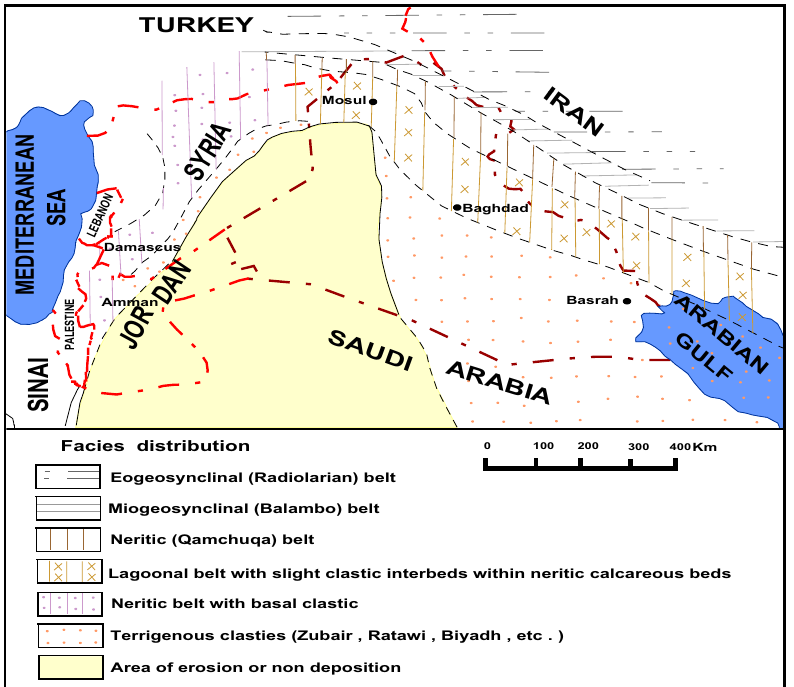
Figure 3. Paleogeography map of the Late Berriasian—Aptian period, modified form 4 by using Didger 3. The miogeosynclinal furrow indicate that in northeastern Iraq the boundary of Balambo trough was formed by ridge indicated by shallow water carcareous sediments in the wider Surkev–Norbab–Avroman area. On the area of unstable shelf, and on the marginal parts of the stable shelf,—three zones, with different sedimentary sequences, can be distinguished in this figure: ( a ) The neritic belt, is relatively broad zone connected with the ridge separating the miogeosynclinal furrow from the basinal areas of the platform. ( b ) The lagoonal belt occupies the rest of the Foothill Zone, and the Mesopotamian Zone. The sediments of the basin are characterized by terrigenous supply, mainly in the basal parts of the sequence Garagu facies and show lagoonal in layers too. ( c ) The sandy zone occupies the rest of the Mesopotamian Zone (the Euphrates Block). The zone is characterized by prevalently terrigenous clastic sedimentation, pelitic and calcareous at the beginning i.e. by the reduced Yamama and the Ratawi Formations and mainly by the mighty Zubair sands. The area extends over the stable shelf on and to the east of the Abu Jir Subzone